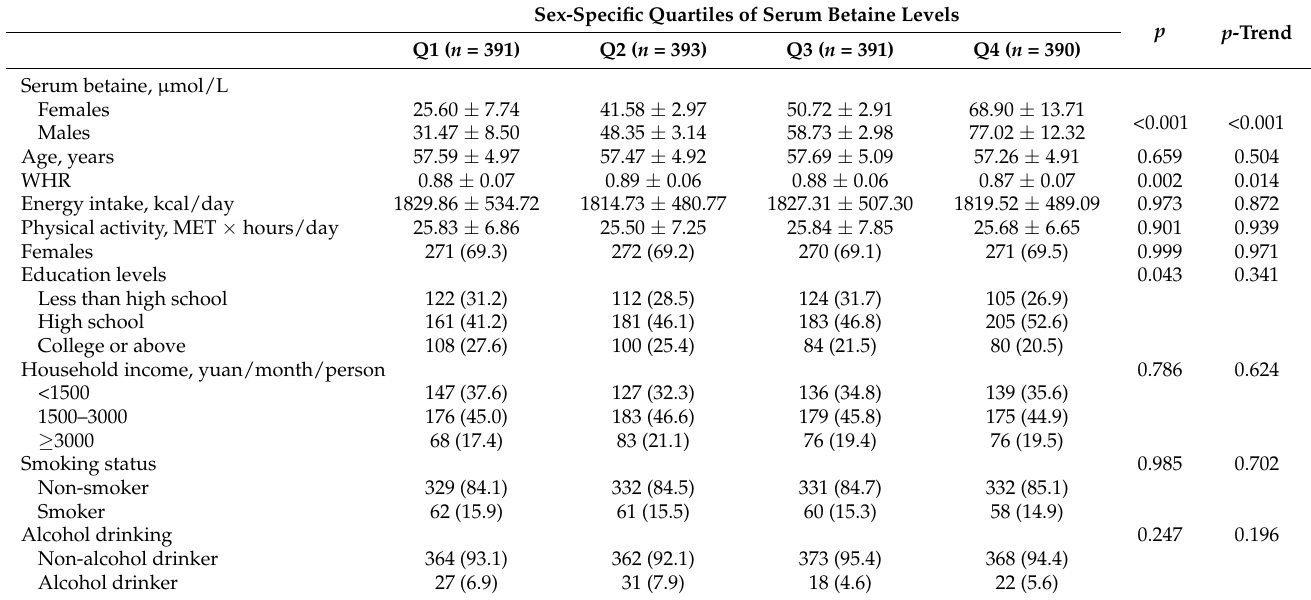
Table 1. Baseline characteristics by sex-specific quartiles of serum betaine levels 1